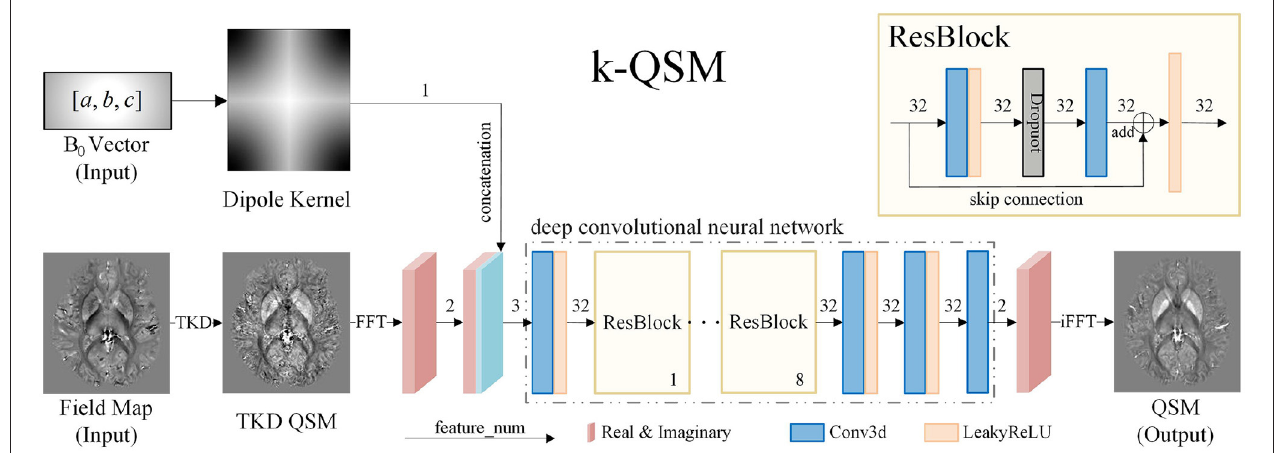
FIGURE 2 | The proposed k-QSM network architecture. The input of the model is B 0 vector and the field map, and the output is quantitative susceptibility mapping (QSM). The input and output of the deep convolutional neural network (DCNN) are both k-space data.